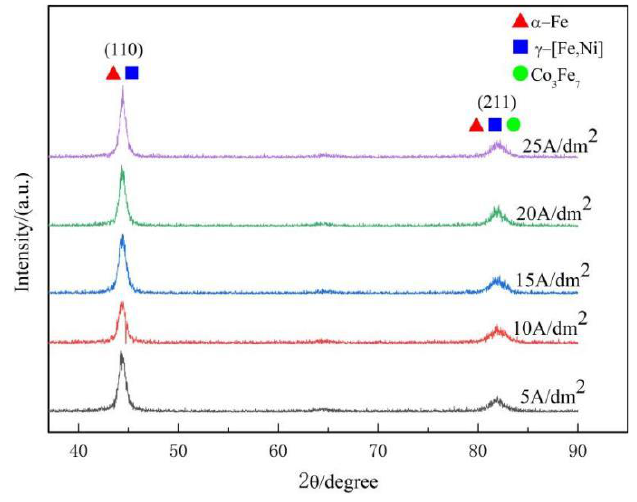
Figure 7. XRD spectra for Fe-Co-Ni electrodeposited coatings at different current densities.